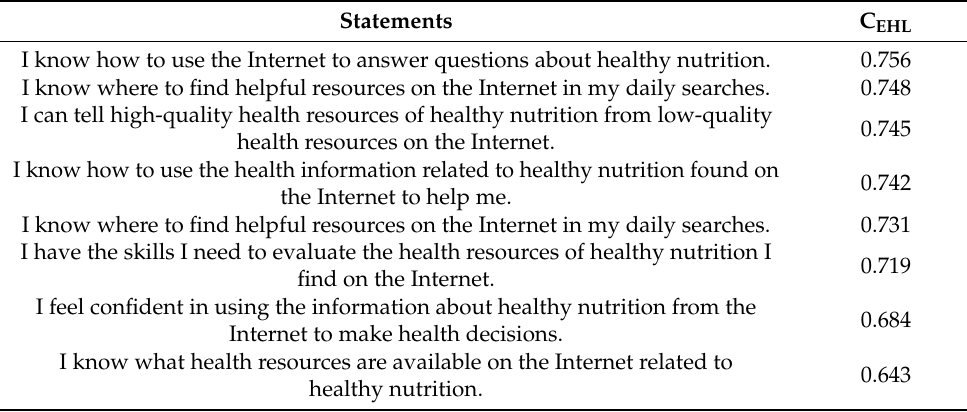
Table 4. Component of electronic health literacy, component